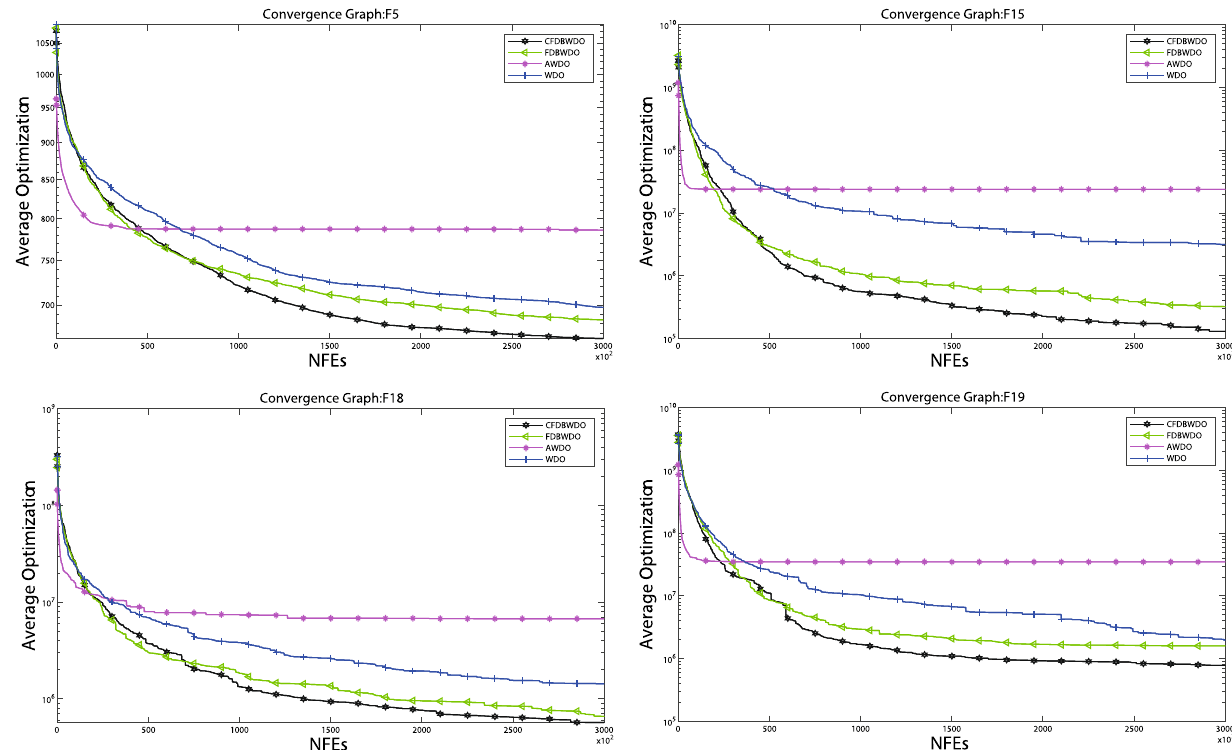
Fig. 5 Box-and-whisker diagrams of four WDO variants on F3, F5, F17 and F30 with 30 dimensions